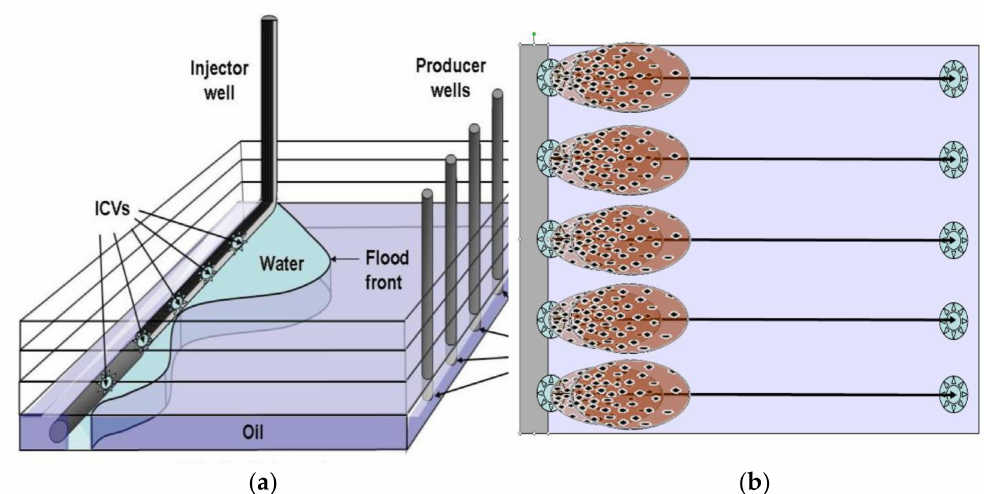
Figure 2. ( a ) Basic well constellation assumed in this study with one horizontal injection well with water rates controlled by five ICVs. Flooding of the oil reservoir occurs by a direct line drive between the inflow control valves (ICV) in the injection well and bottomhole assemblies (BHA) of the five vertical producer wells, where pressure can be monitored. After Weijermars et al. [10]. ( b ) Top view of the average 2D flow paths (from left to right) in the planar reservoir zone with schematic of plumes (brown) formed by diffusion of instantaneous tracers placed in injection